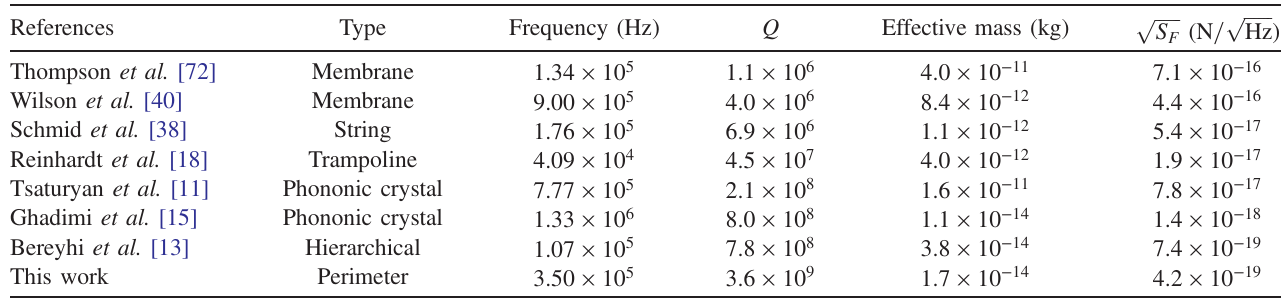
TABLE I. Comparison of room temperature force sensing parameters for different types of mechanical